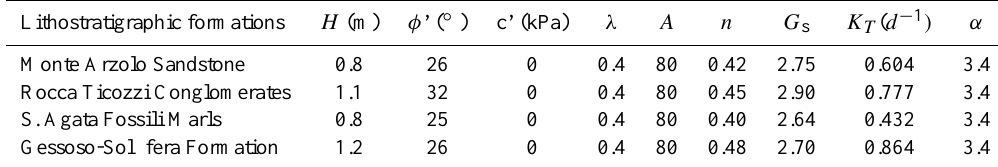
Table 4. Input parameters for the SLIP model. Lithostratigraphic